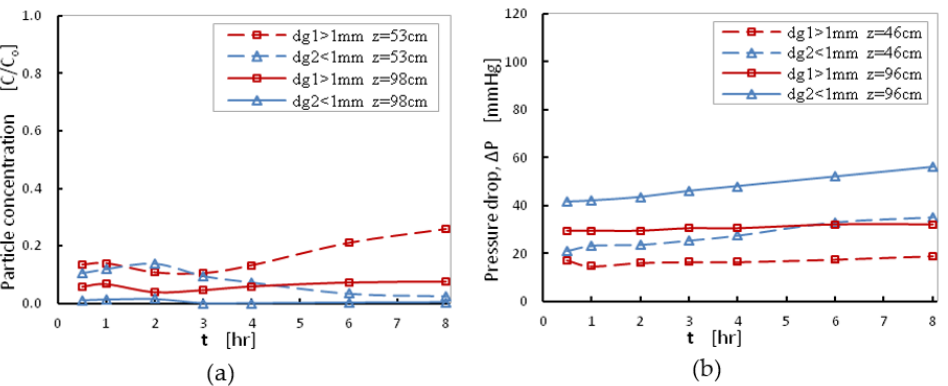
Figure 7. ( a ) Normalized particle concentration and ( b ) Pressure drop, as functions of duration time, at two different depths of the filter and two grain size distributions for packing material, at C 0 = 70NTU and V = 1.85 mm/s.